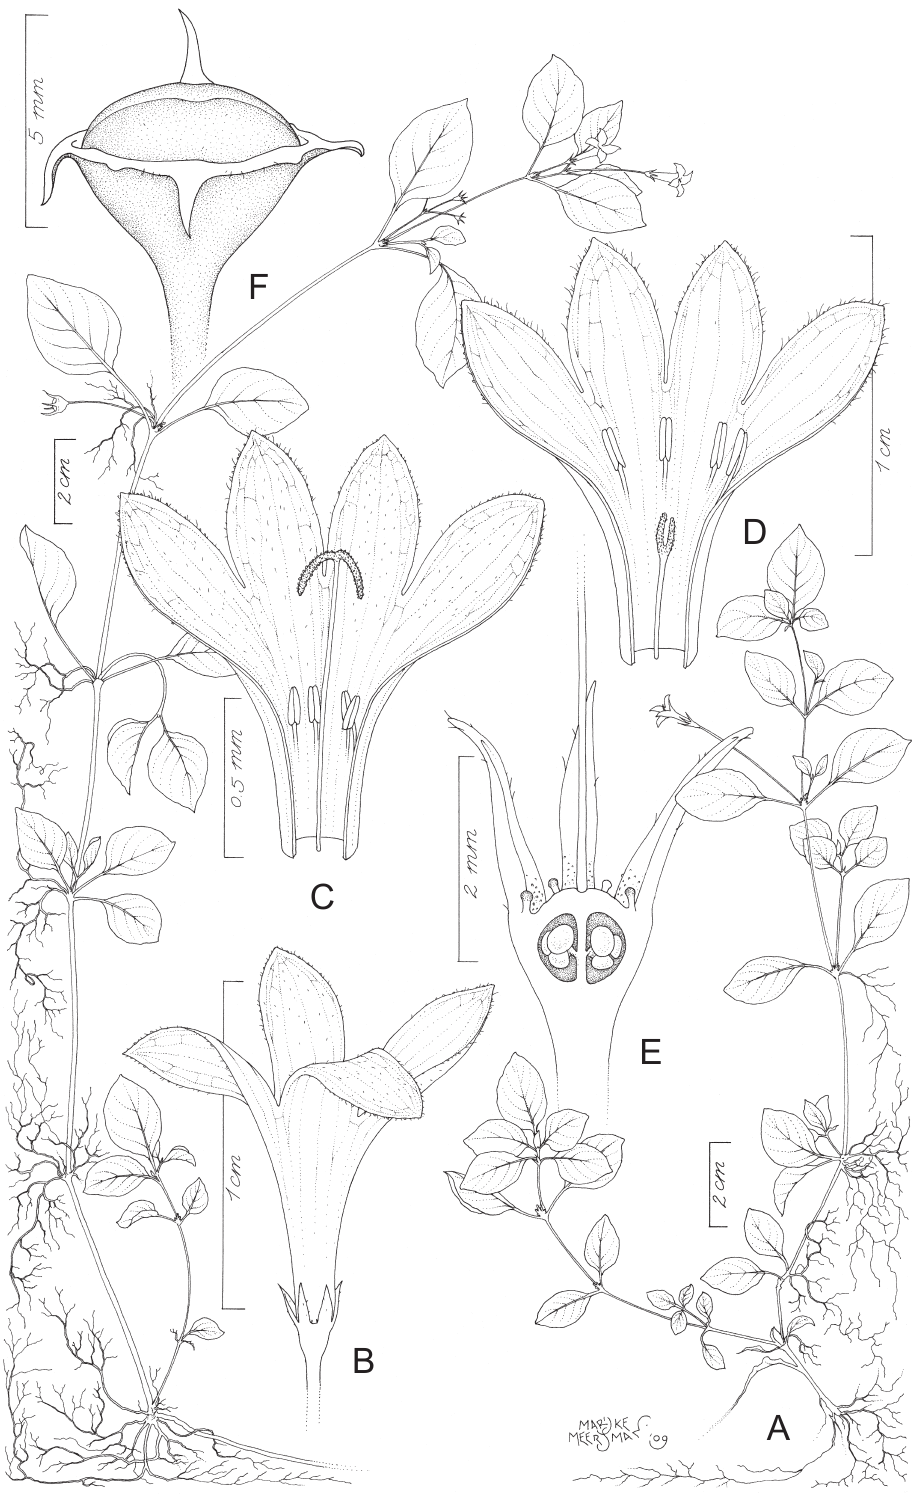
Fig. 16. Astiella tsaratanensis Groeninckx sp. nov. A . Habit. B . Brevistylous flower. C . Open longistylous flower. D . Open brevistylous flower. E . Ovary dissected to show placentation. F . Capsule. Drawn by Marijke Meersman. A–C, E–F from De Block, Rakotonasolo & Randriamboavonjy 1319 (BR); D from Humbert & Capuron 24975